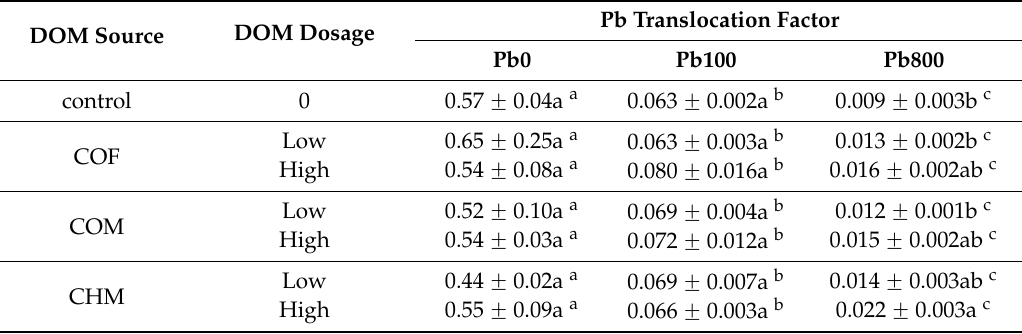
Table 4. Translocation factor of Pb from soil to shoots of Brassica chinensis (shoots/soil) treated with varying amounts of DOM from different sources at different soil Pb levels.